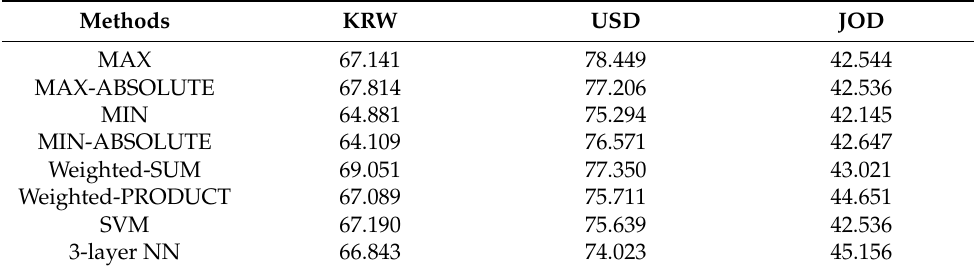
Table 6. Experimental results of training on EUR and testing on the other currency types using the proposed fusion methods on two additional CNN classifiers. (Measure: mAP, unit: %).